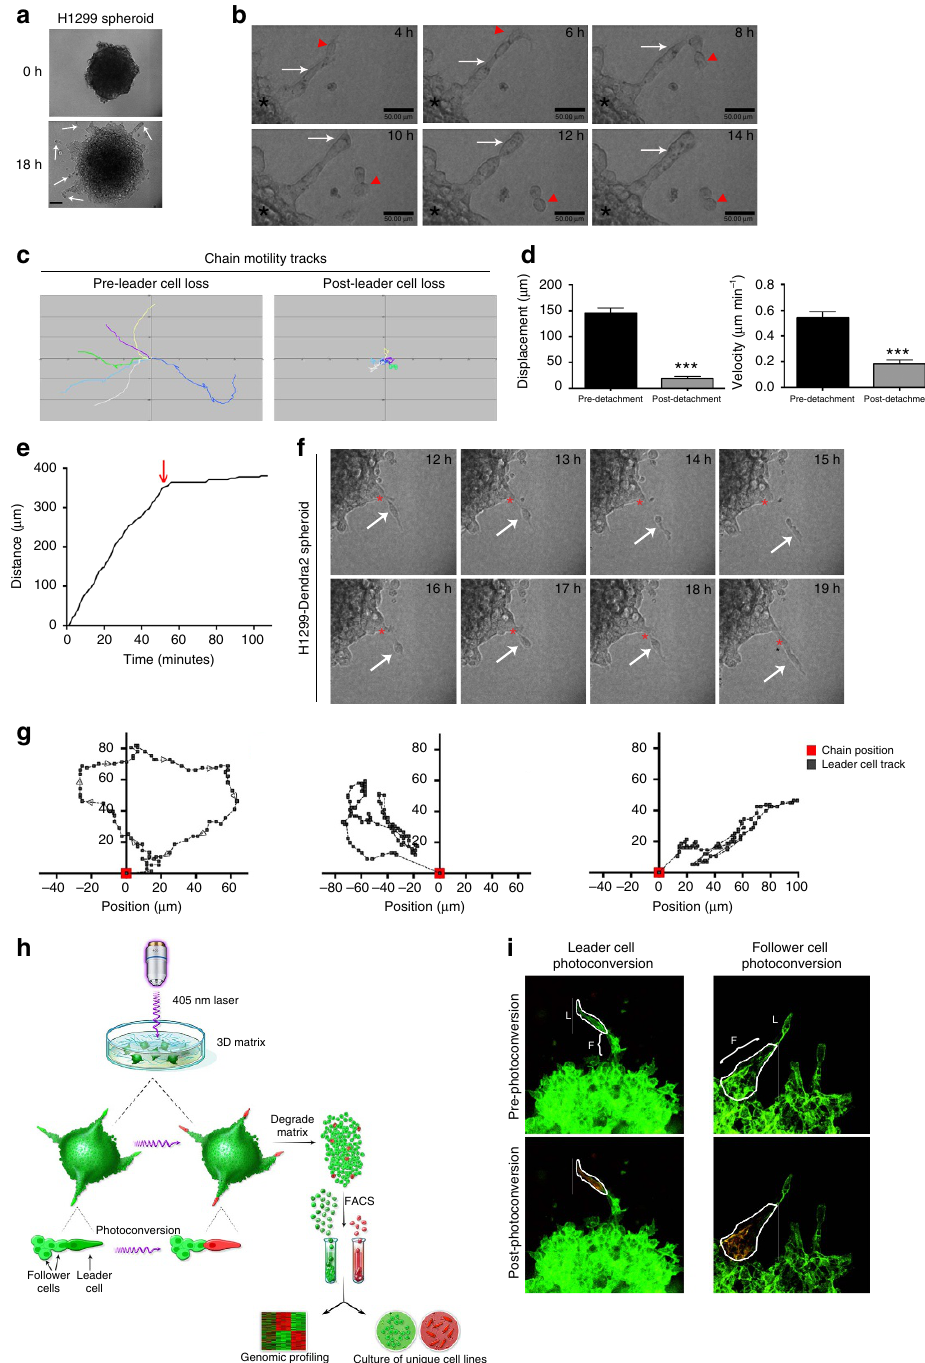
Figure 1 | Leader cells represent a specialized subpopulation which can be purified using SaGA. ( a ) H1299 spheroids were imaged at 0h (top) and 18h (bottom) post embedding. Arrows, leader–follower invasive chains. ( b – f ) H1299 spheroids imaged using live cell confocal imaging. ( b ) Time lapse of H1299 spheroids acquired every 2h. Arrow, follower cells in invasive chain; arrowhead, leader cell. ( c ) Invasive chains were tracked over time before (pre-leader cell loss) and after (post-leader cell loss) a leader cell becomes detached from the chain. Cell track plots are shown where each colour represents a single chain. ( d ) Quantification of track displacement and velocity of invasive chains from c . n ¼ 6. Error bars denote the s.e.m. *** P o 0.001, using a Student’s t - test. ( e ) Single invasive chain distance tracked over time. Arrow ¼ point of leader cell detachment. ( f ) Representative still images of live cell imaging of H1299 spheroids taken every hour. Arrow denotes the leader cell, asterisk denotes the follower cell chain. ( g ) Three leader cells were tracked after the time of detachment from the rest of the chain. The position of each leader cell (grey track) is plotted relative to the position of the chain from which it detached (red point). ( h ) Schematic showing the process of the SaGA technique (see methodology for details). Printed with permission from Fairman Studios, LLC. This image is not included in the Creative Commons licence for the article. ( i ) Photoconversion examples using 3D spheroids of H1299-Dendra2 cells. F, follower cells; L, leader cell.